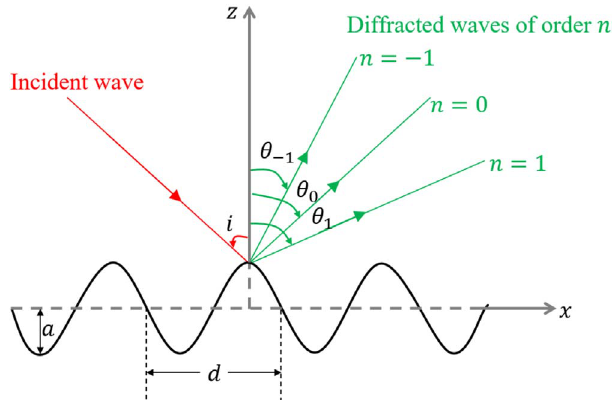
Figure 1. Schematic representation of the re fl ection of a harmonic plane wave from a periodic rough